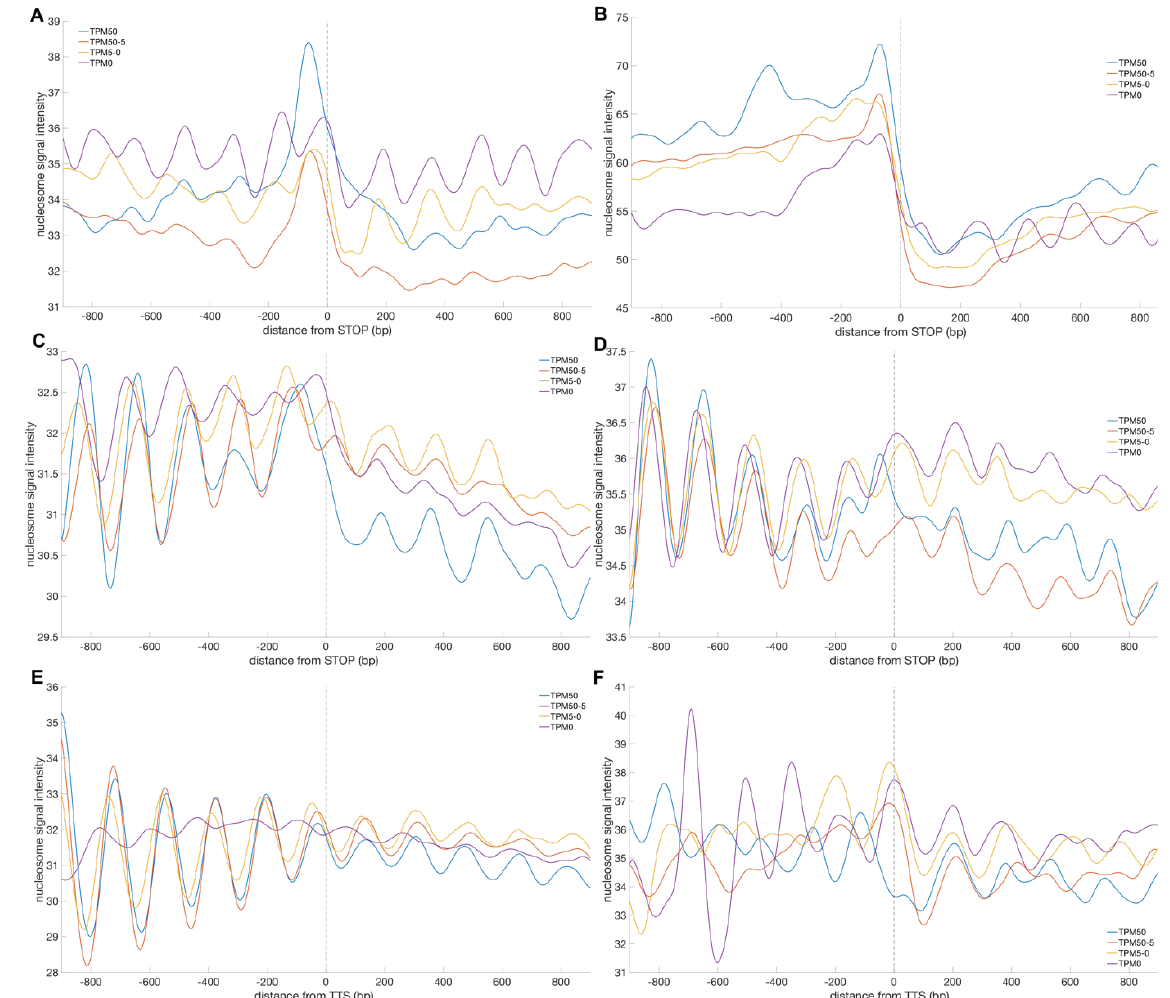
Supplementary Figure 9. Nucleosome organisation at stop codons/TTS vs. gene expression. Average (three biological replicates for each fungus/condition) nucleosome signal as a function of position (in base pairs) relative to the stop codon (and TTS for F. graminearum and B. cinerea ). TPM = Transcripts Per Million. A. In Lmb, Stop-centred; B. In Lml, Stop- centred; C. In B. cinerea , Stop-centred; D. F. graminearum , Stop-centred; E. In B. cinerea , TTS-centred; F. F. graminearum ,